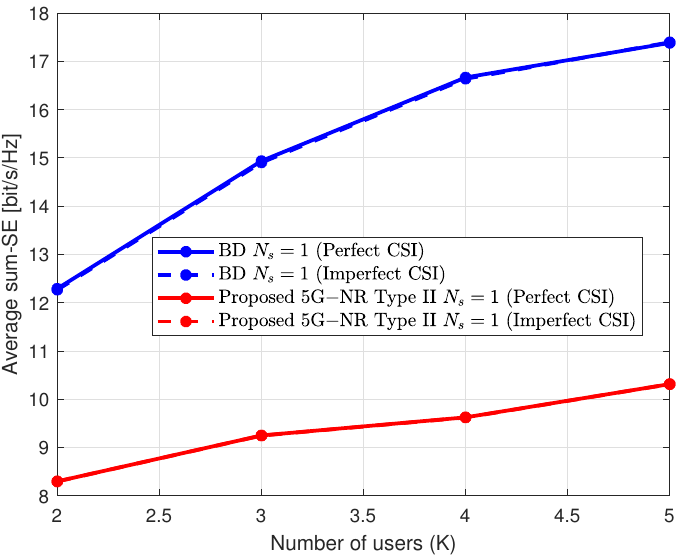
Figure 11. Average SE vs. number of users ( 𝐾 ) for MU-MIMO systems assuming 𝑁 𝑡 = 32, 𝑁 𝑟 = 4, 𝑁 𝑠 = 1, and SNR=5dB. The gNB is implemented assuming a single-panel ULA with 𝑁 𝑁 2 = 1. Imperfect CSI is also assumed with